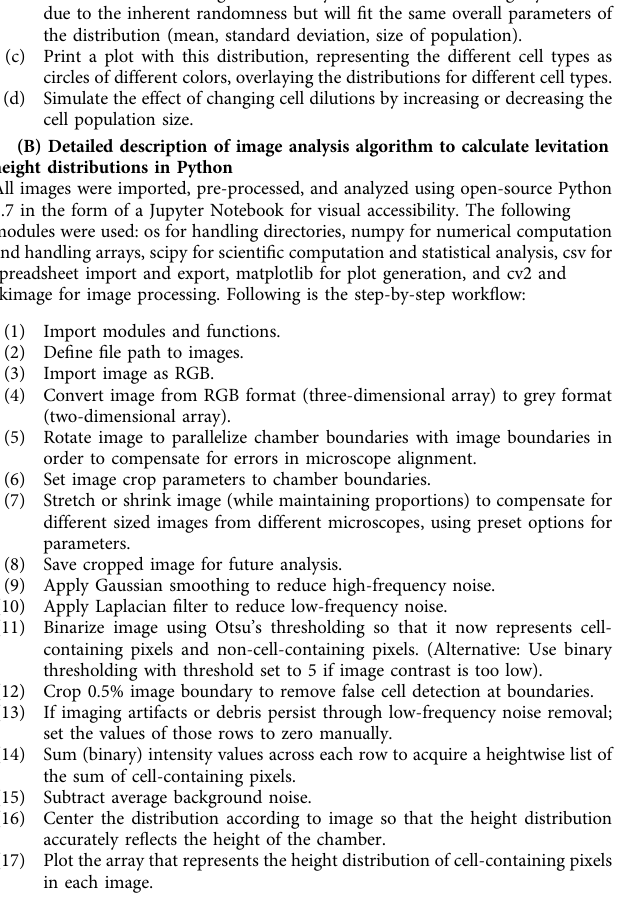
Fig. S11a, b. As expected with such a small dataset, the classi fi cation performance is not very strong, but is promising for continued exploration with a larger dataset. Detailed methods: explanation of custom code and algorithms (full code uploaded to fi gshare 72 )